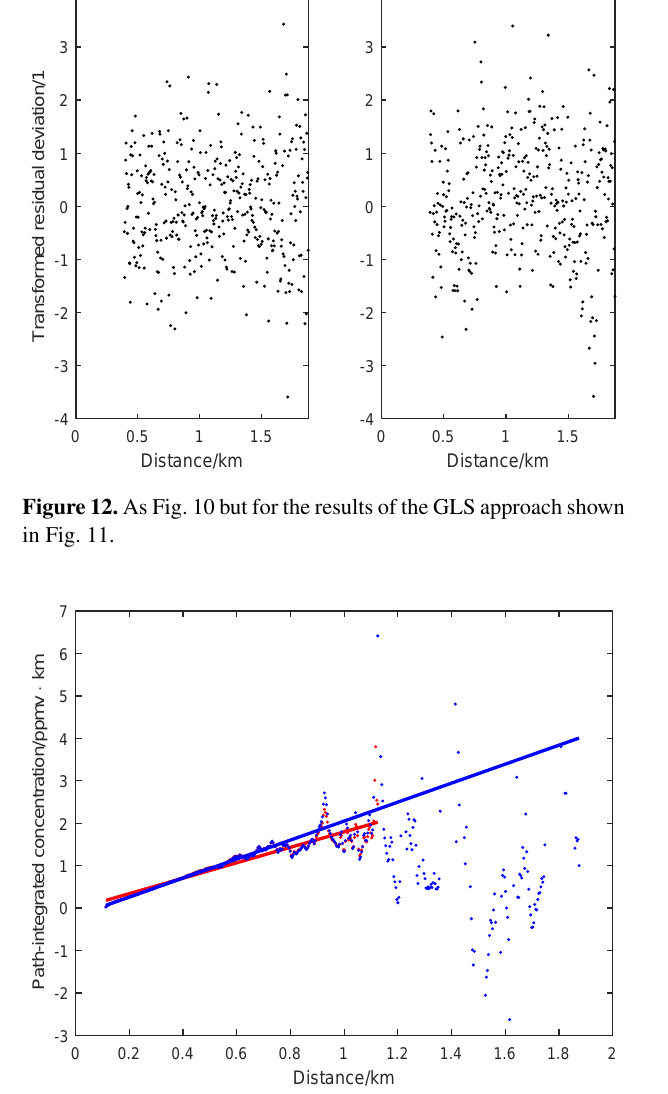
Figure 13. As Fig. 9 but for the GLS approach applied to the data with indices m LOW to m HGH .